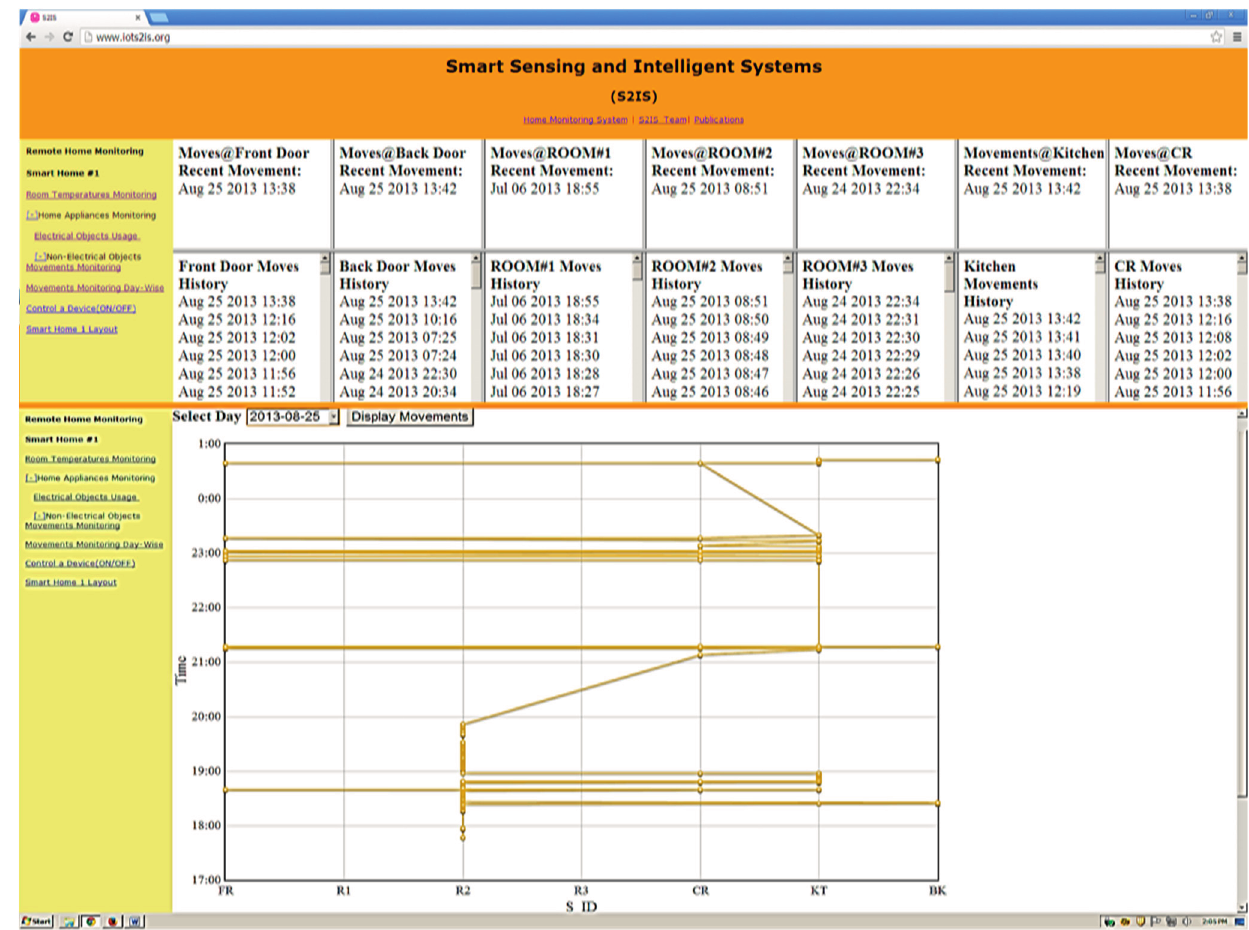
Figure 6. Online smart home monitoring website